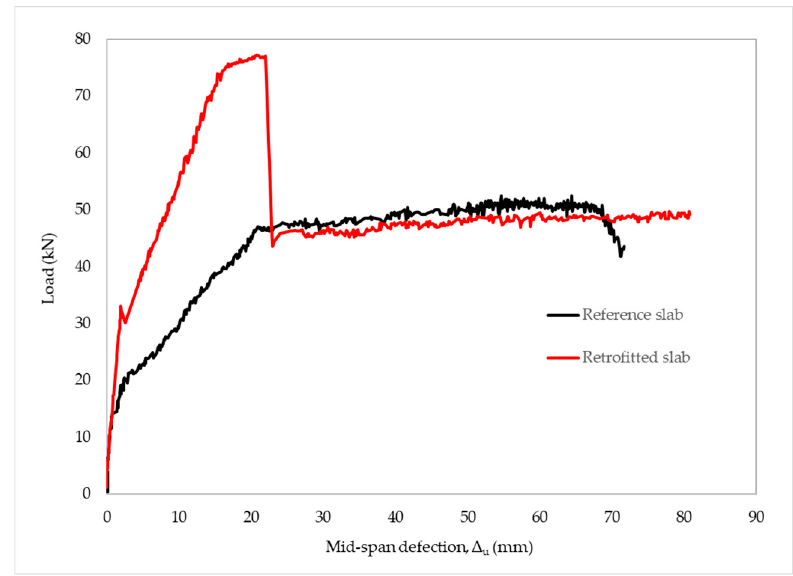
Figure 9. Load–deflection relationship for reference and retrofitted RC slabs.